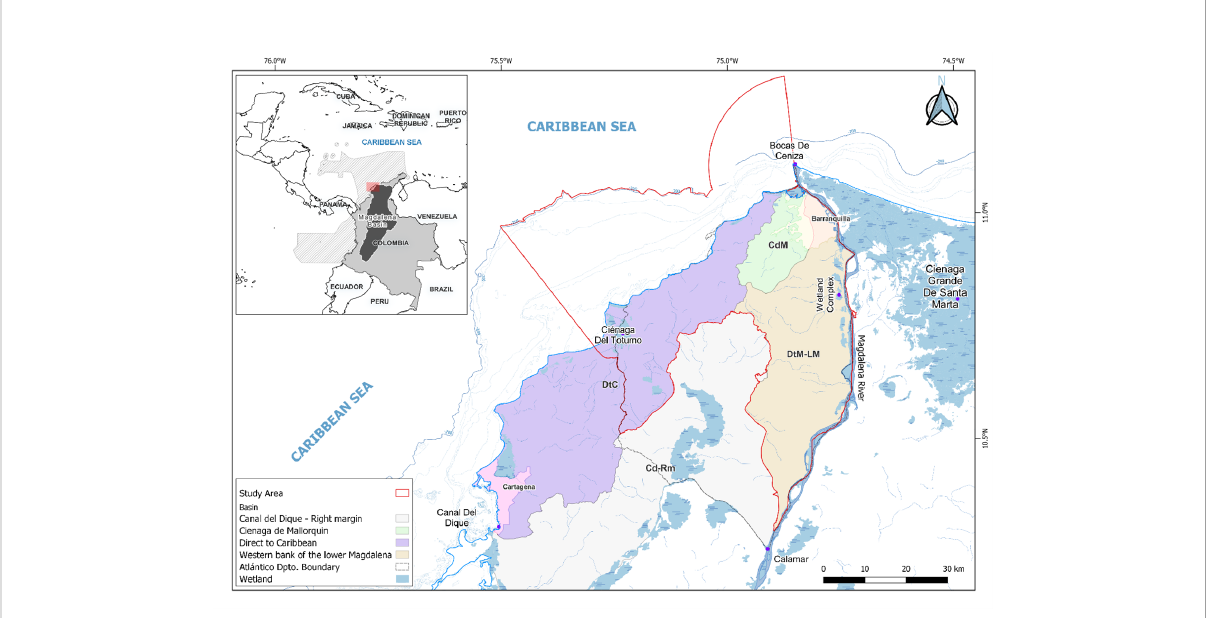
FIGURE 1 Location of the study area (CRS: EPSG 4326 – WGS